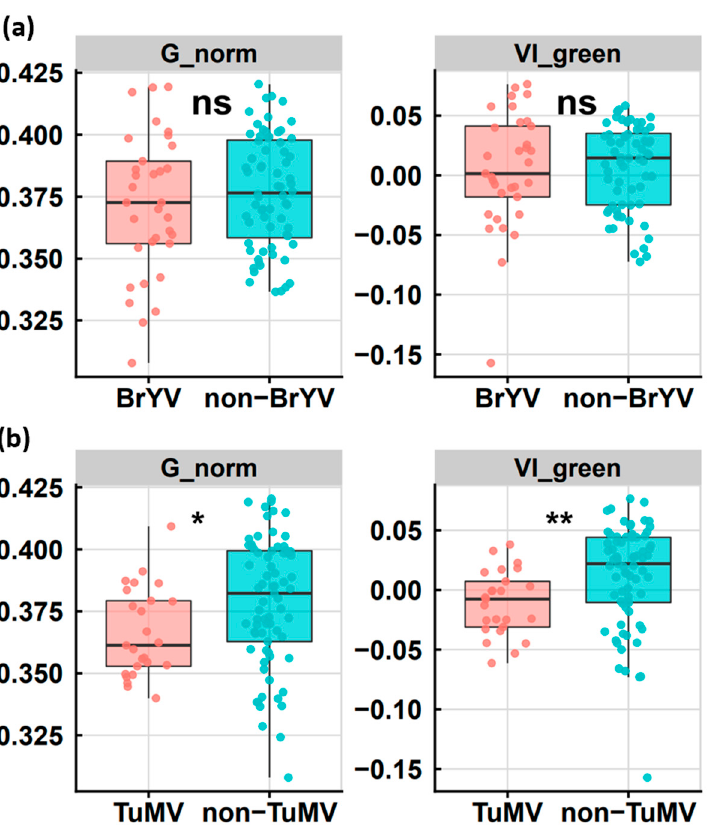
Figure 3 . The comparison of leaf color values between virus-infected and non-infected plants. ( a ) The difference in leaf color values between BrYV-infected (pink) and non-infected (blue) plants. ( b ) The difference in leaf color values between TuMV-infected (pink) and non-infected (blue) plants. The leaf color values were estimated by the parameters G_norm ( left ) or VI_green ( right ). Student’s t-test was used for hypothesis testing. Single asterisk indicates a p value < 0.05 and double asterisks indicate a p value < 0.01.